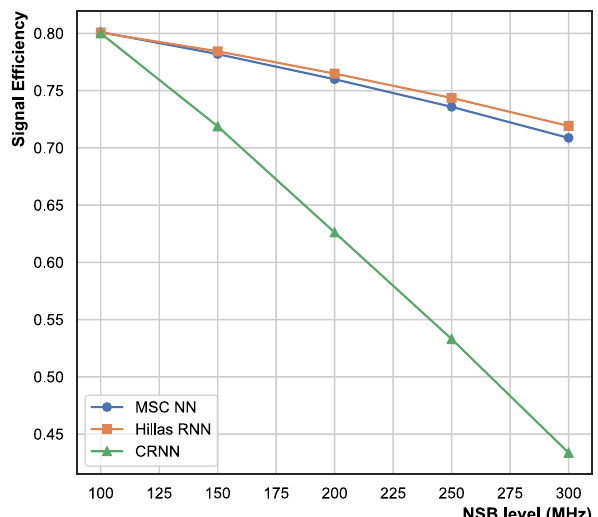
Fig. 6 Degradation in signal (gamma-ray) efficiency for the three tested networks as a function of NSB level